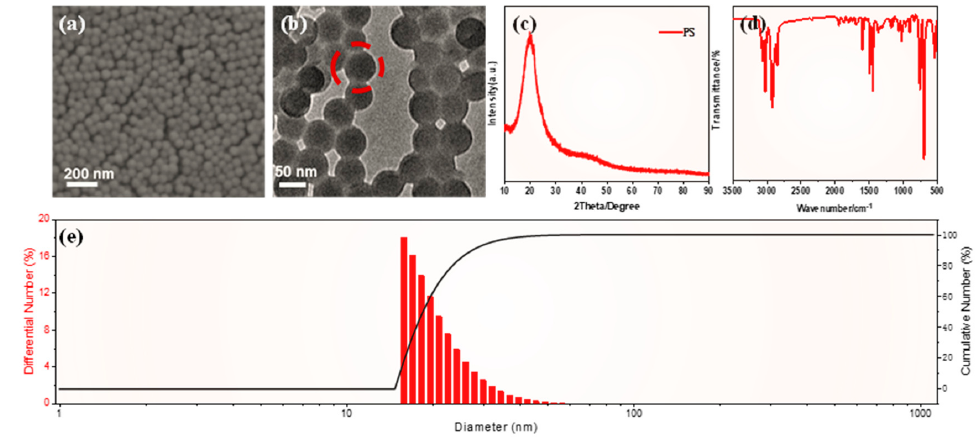
Figure 1. ( a ) SEM images of polystyrene microspheres. ( b ) TEM images of polystyrene microspheres. Fig 1 in manuscript ( c ) X-ray diffraction (XRD) patterns of polystyrene microspheres. ( d ) FT-IR spectrum of polystyrene microspheres. ( e ) Particle size analysis chart of polystyrene